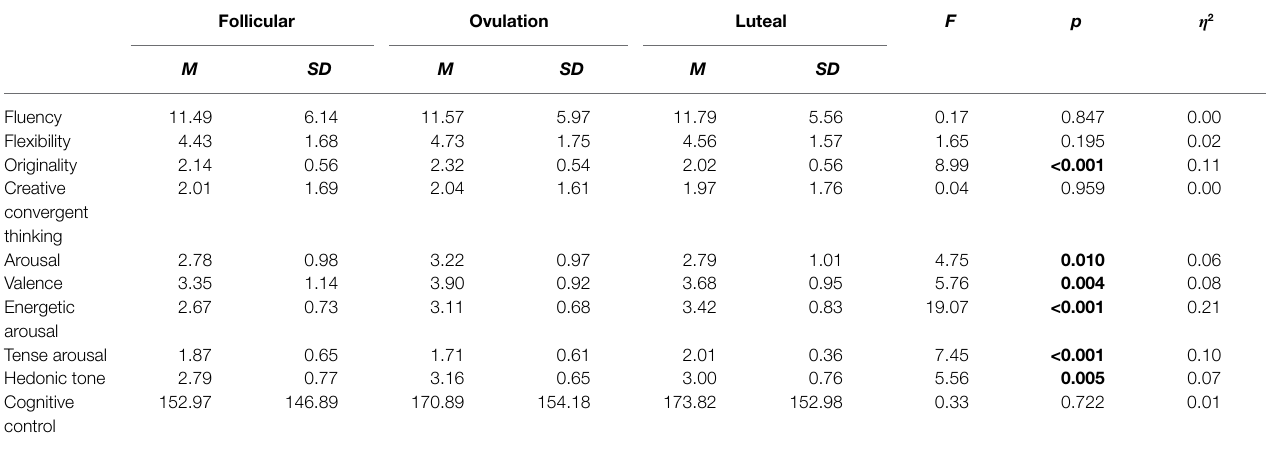
TABLE 1 | Differences between ovulatory cycle phases in terms of variables